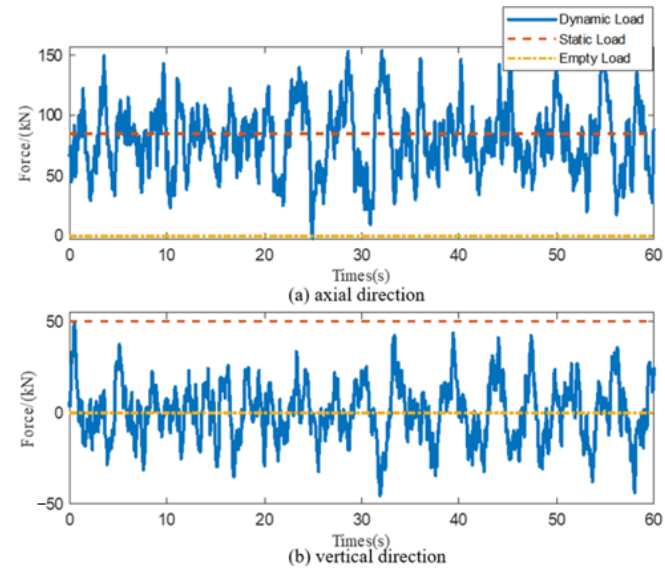
Figure 9. Three loading forces. ( a ) axial direction; ( b ) vertical direction. Table 3. Condition number of each running condition.